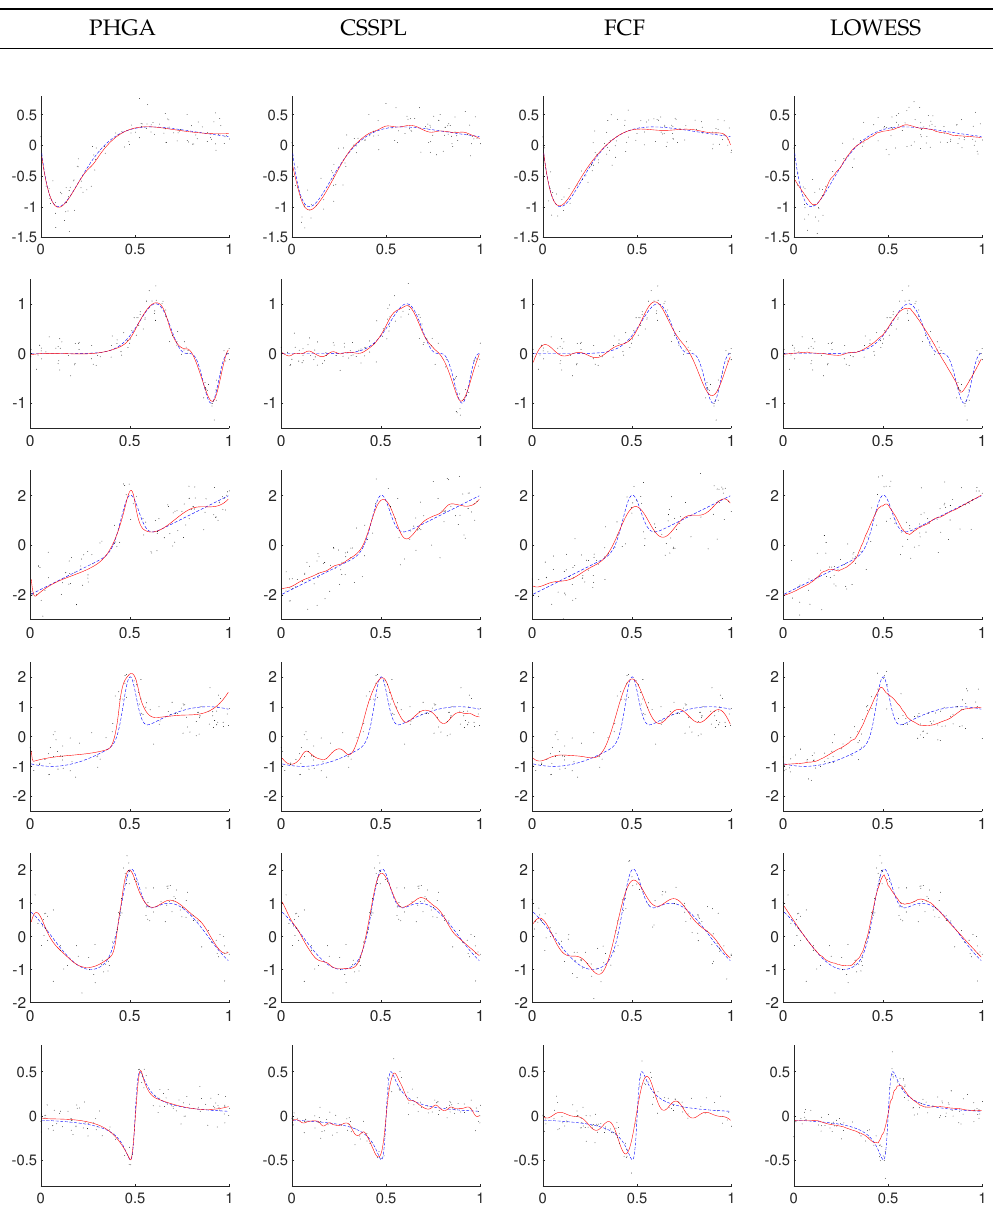
Figure 8. Data and best fitting with SNR = 2 for PHGA, CSSPL, FCF and LOWESS methods (solid line: estimated function; dashed line: real